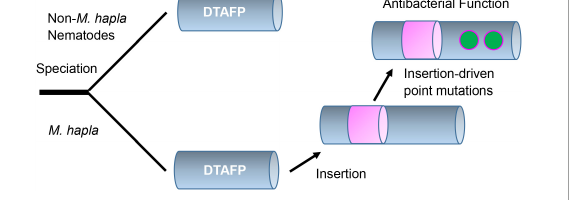
Proposed evolutionary history of mehamycin. In this evolutionary scenario, the ancient drosomycin-type antifungal peptide (DTAFP) gained an insert after speciation from other nematodes, which further drove point mutations at key sites located on its flanking core scaffold region and ultimately led to the emergence of antibacterial function. The insert is represented by a pink cylinder and point mutations are represented by green dots.